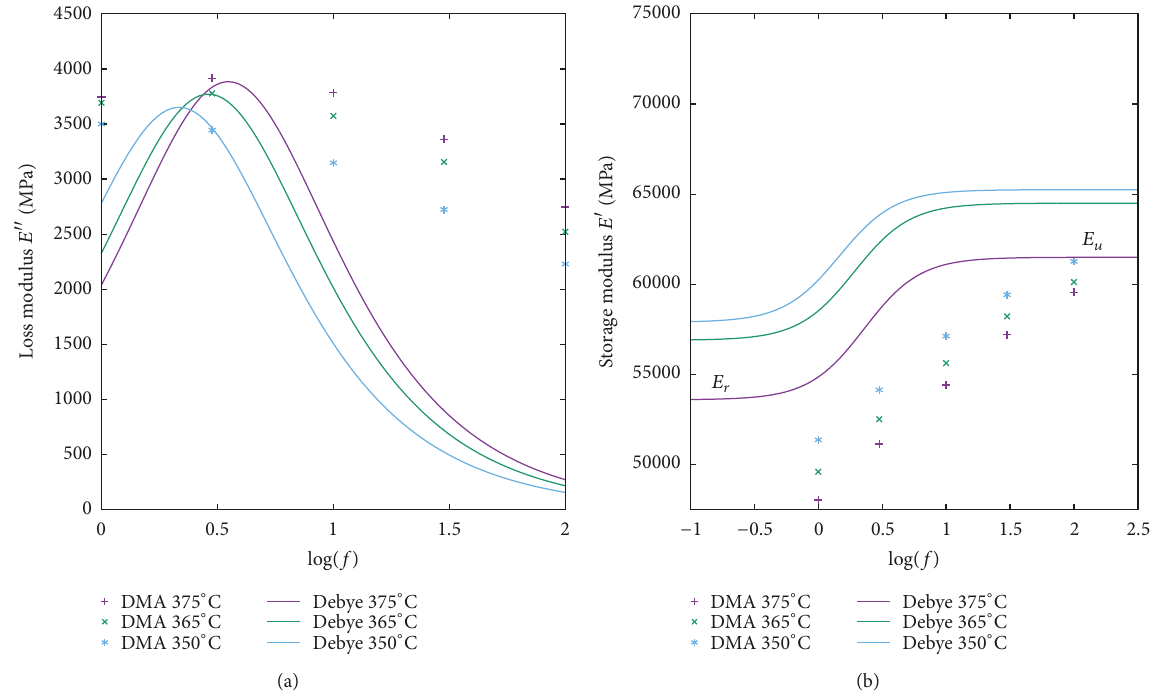
Figure 9: From DMA tests on AA 7075-T6 at 350, 365, and 375 ∘ C: isothermal loss modulus 𝐸 󸀠󸀠 versus logarithm of the frequency 𝑓 and Debye peaks as given by Debye equation (a); and storage modulus 𝐸 󸀠 versus logarithm of the frequency 𝑓 as given by Debye equation (b). 𝐸 𝑢 and 𝐸 𝑟 are the unrelaxed and relaxed dynamic Young’s moduli, respectively.